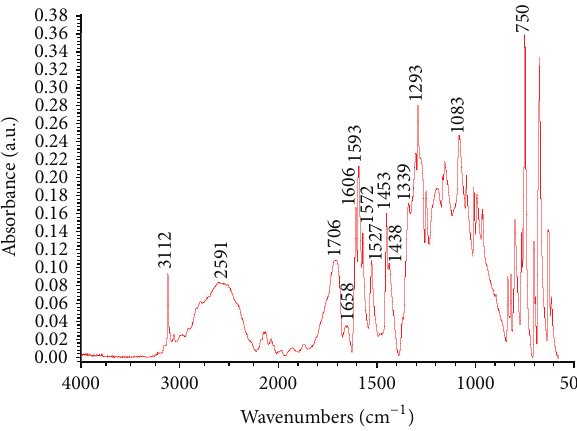
Figure 1: Infrared spectrum (4000–500 cm −1 ) of picolinic acid.